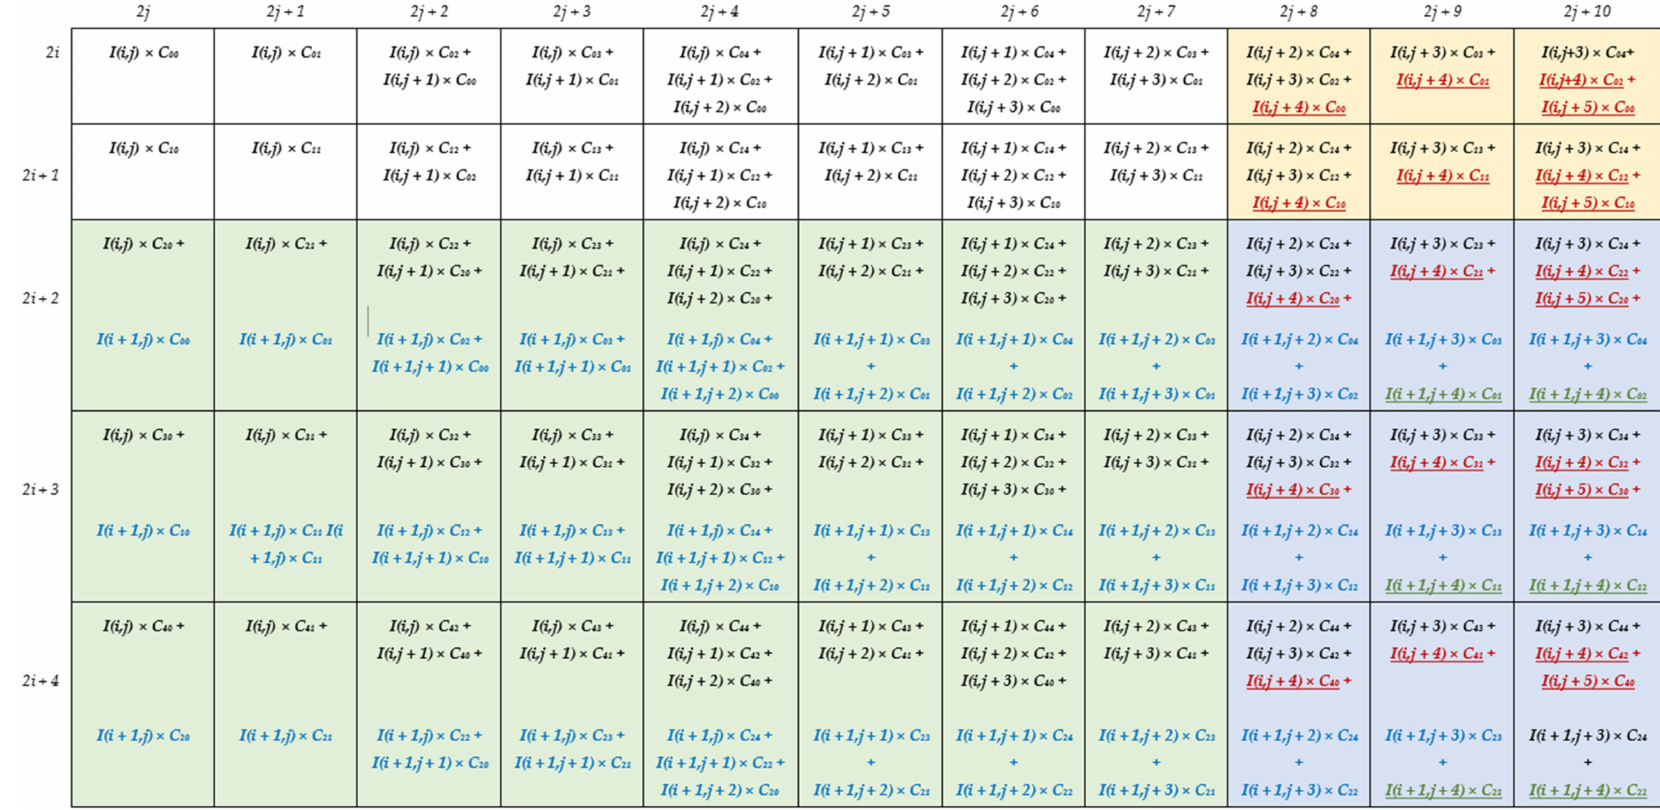
Figure 7. The operations performed by the generic DU when P N = 4, K = 5, S = 2. Black: operations performed at the current clock cycle; red: operations performed at the next clock cycle; blue: operations performed on the pixels belonging to the ( i + 1)-th row and the ( j ), ... ( j + 3)-th columns; green: operations performed on the pixels belonging to the ( i + 1)-th row and the ( j + 4)-th